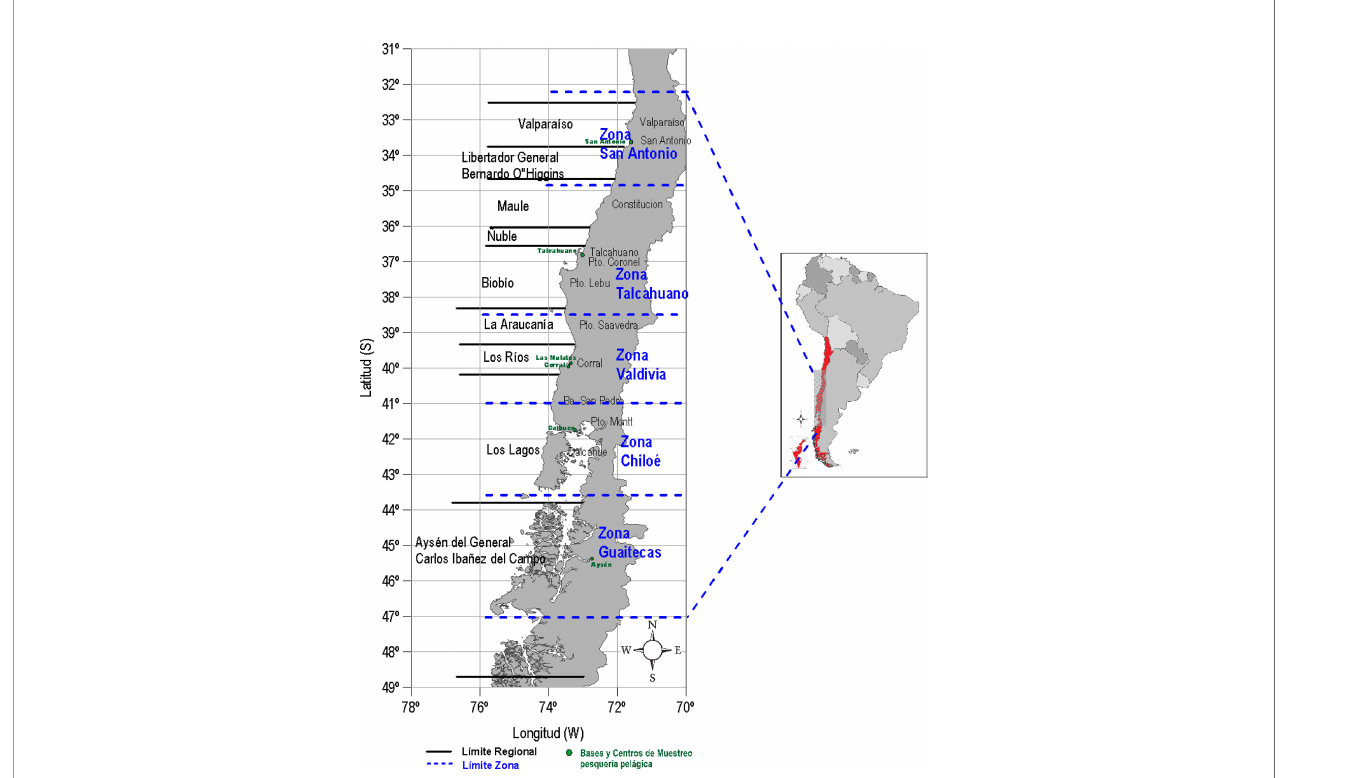
FIGURE 1 | Fishing zones and administrative regions of central-south Chile (31° – 49° LS).